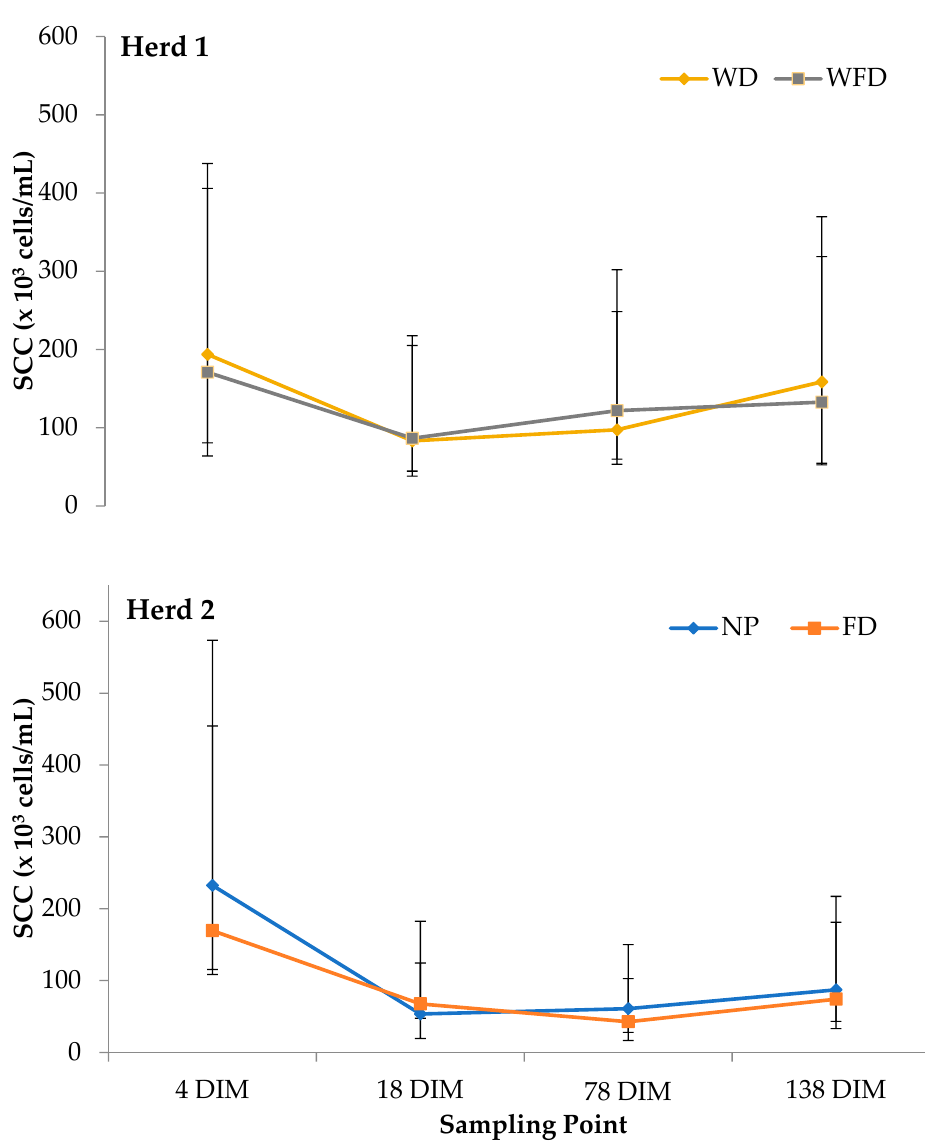
Figure 1. Geometeric mean somatic cell count (SCC) (× 10 3 cells/mL) for four pre-milking teat disinfectant treatments on two herds (Herd 1: WD = wash and dry wipe and WFD = wash, foam application and dry wipe; Herd 2: NP = no teat preparation and FD = foam appliaction and dry wipe) at four sampling points (4 DIM, 18 DIM, 78 DIM, 138 DIM) during the study. Error bars indicate lower and upper 95% confidence intervals. Table 1. Treatment difference ratios of log values (95% confidence limits) for the difference in somatic cell count (SCC) of four pre-milking teat treatments (WD = wash and dry wipe; WFD = wash, foam application and dry wipe; NP = no teat preparation; FD = foam application and dry wipe) for two herds (herd 1 and 2) at four sampling points during the study. Herd 1 WD vs. WFD